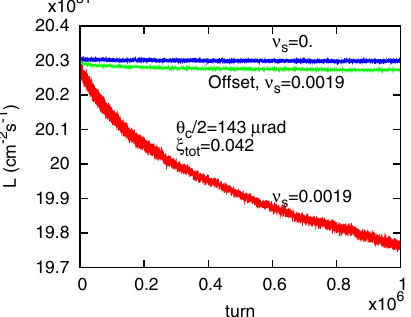
FIG. 8. Resonance lines and their widths in the amplitude space given by Taylor map analysis for a horizontal/horizontal crossing. The units on the horizontal and vertical axes are equivalent to x= σ y= σ x and y